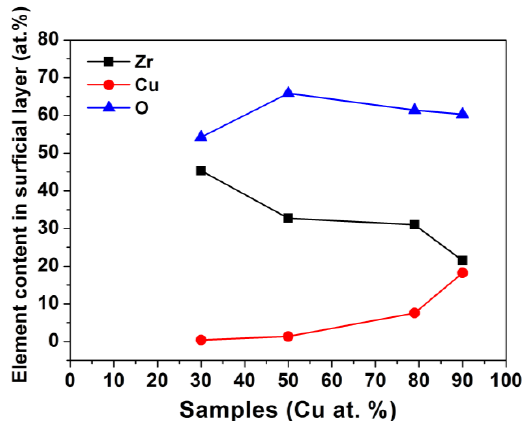
Figure 8. The element content of surficial layers of Zr-Cu glassy coatings by XPS.